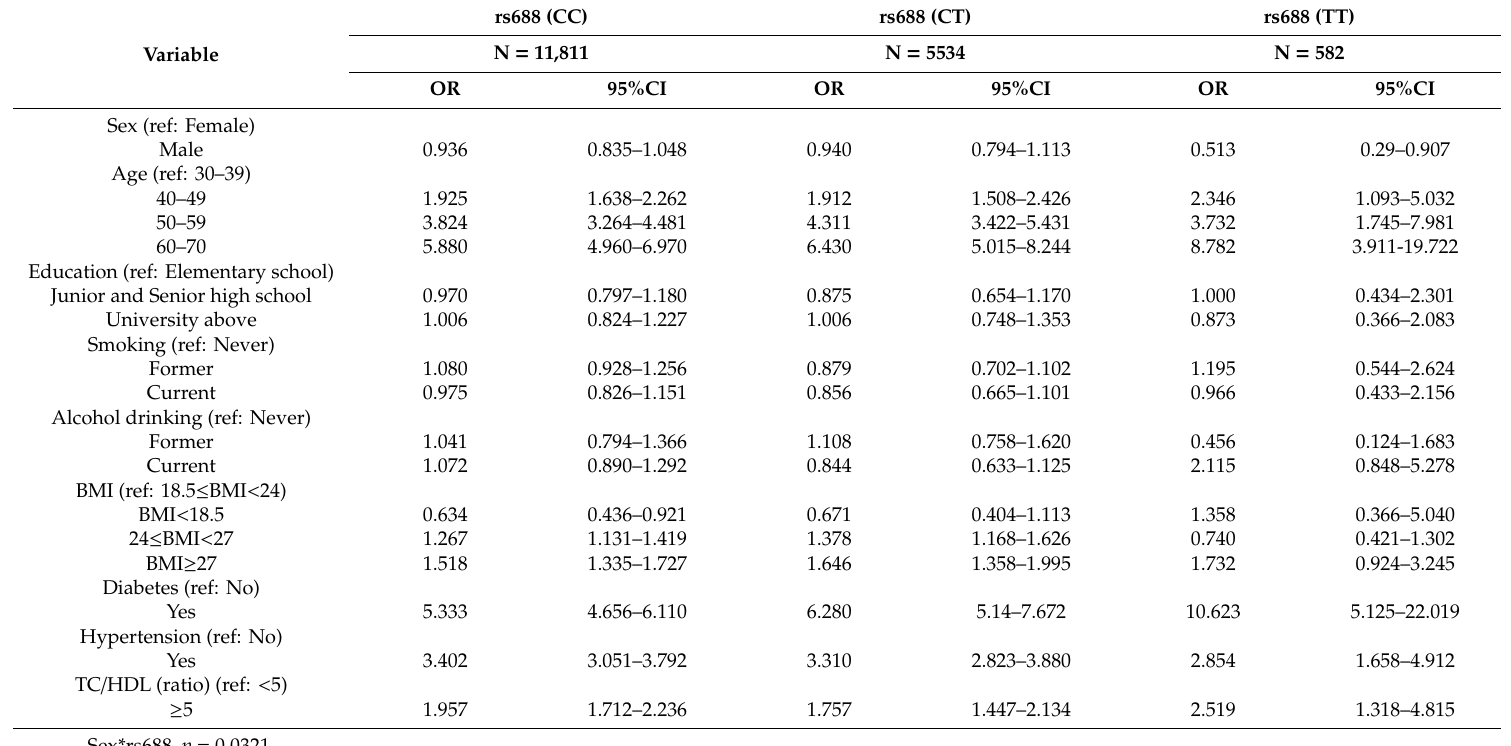
Table 3. Odds ratios for hyperlipidemia based on rs688